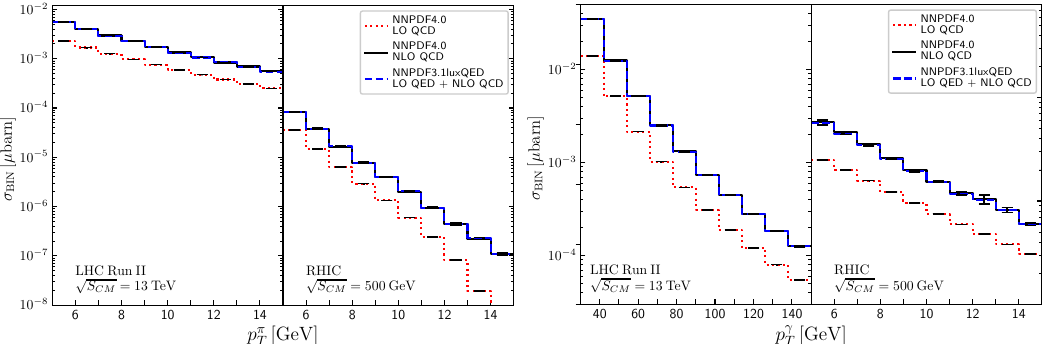
Figure 1: Unpolarized cross-section for the production of one photon plus one pion as a function of the transverse momentum of the pion (left) and the photon (right), respectively. We considered the selection cuts described in the previous section, for LHC Run II and RHIC,